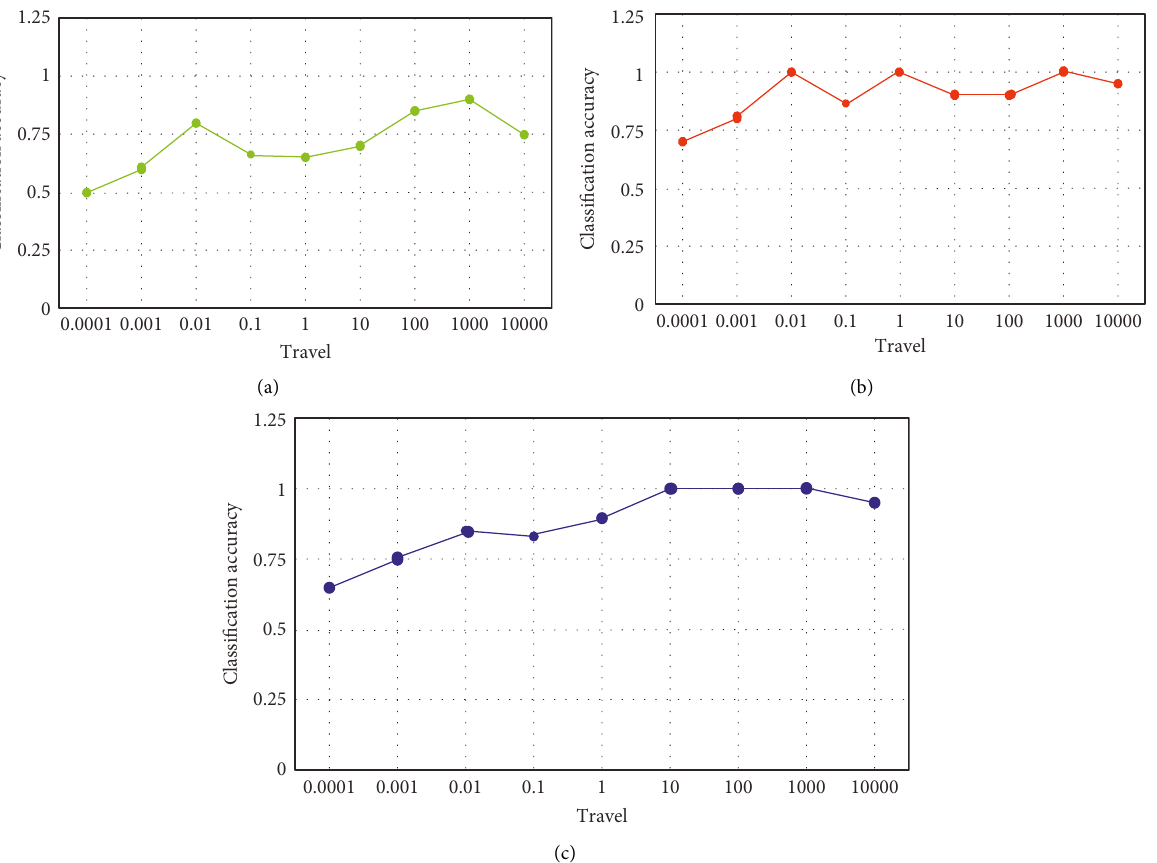
Figure 8: Sensitivity curves for item weights in the travel dataset for three classes of objective functions: (a) D1 dataset sensitivity, (b) D2 dataset sensitivity, and (c) D3 dataset